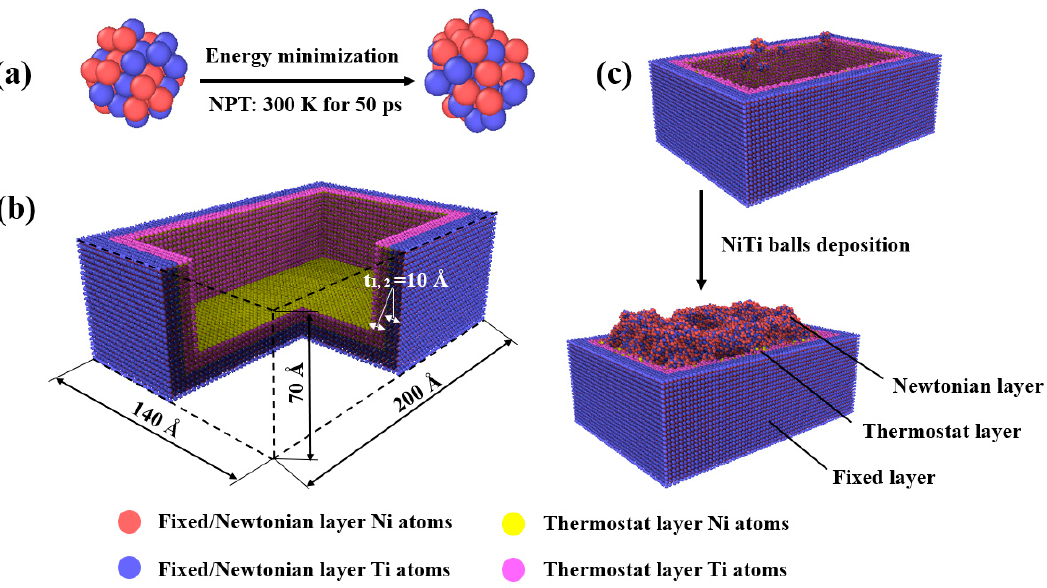
Figure 1. Deposition process: ( a ) preparation of granulated NiTi powder, ( b ) the model of deposi- tion tank, where t 1 and t 2 are the wall thickness, and ( c ) granulated NiTi powder deposition process.